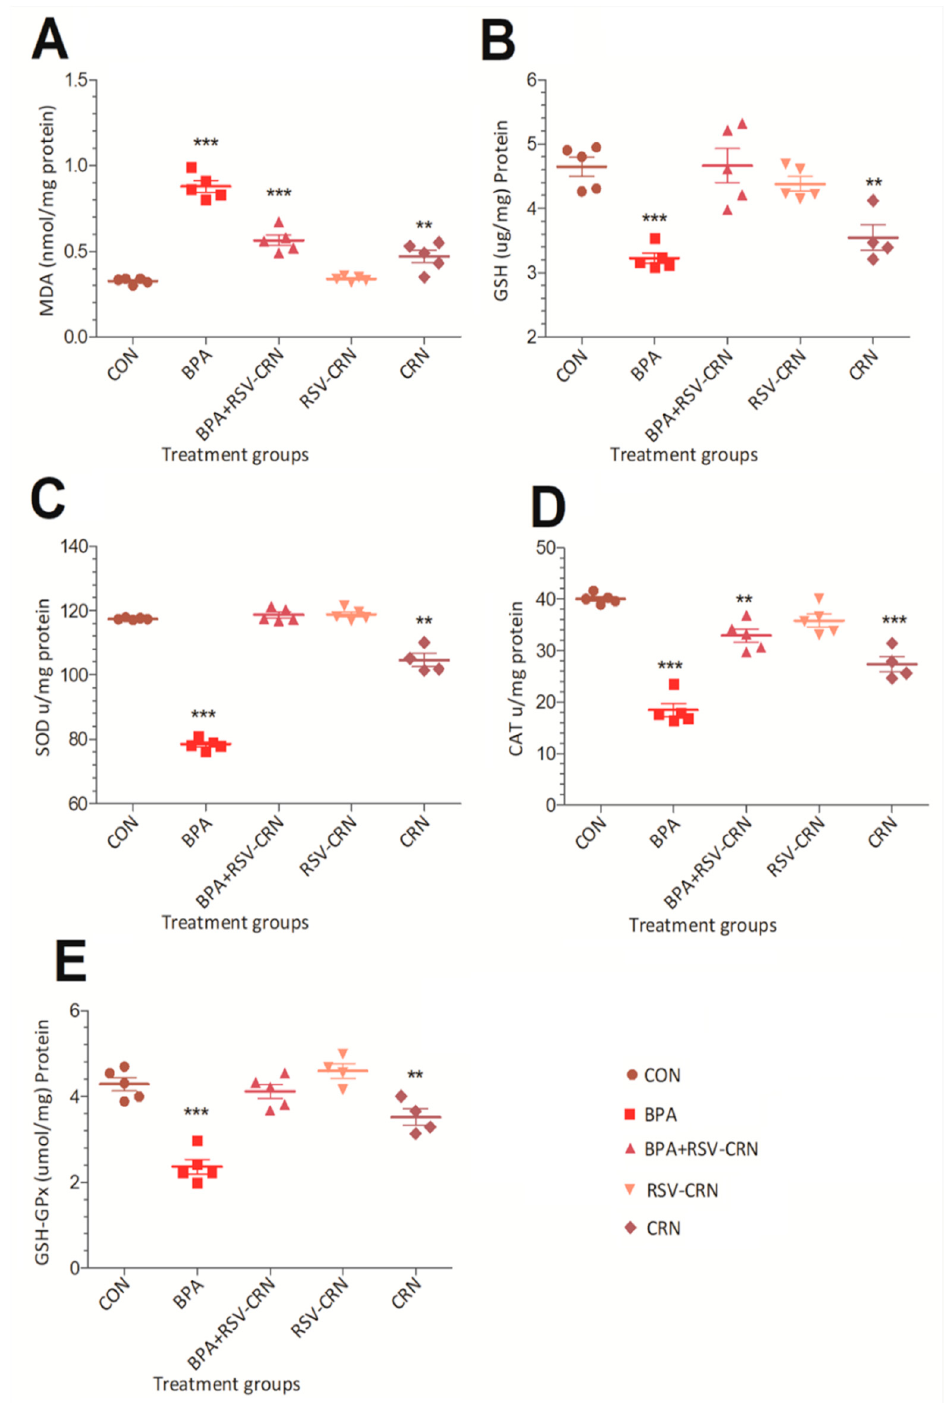
Figure 3. Effect of BPA on peroxidation biomarkers and antioxidant enzymes ( A ) MDA, ( B ) GSH, ( C ) SOD, ( D ) CAT, and ( E ) GPx, and the ameliorative effect of RSV. The level of GSH, SOD, CAT and GPx were decreased at the end of experiment while MDA levels were enhanced. The data were analyzed using one-way ANOVA. The results are expressed as the mean ± SD. ** shows the level of significance where *** means a highly significant difference from the control group. Abbreviations: GSH: Glutathione; SOD: Superoxide dismutase; CAT: Catalase; GPx: Glutathione peroxidase; MDA: Malondialdehyde; CON: Control group; BPA: BPA receiving group; BPA+RSV-CRN: BPA and resveratrol blended in corn oil group; RSV-CRN: resveratrol blended in corn oil group; CRN: Corn oil group.